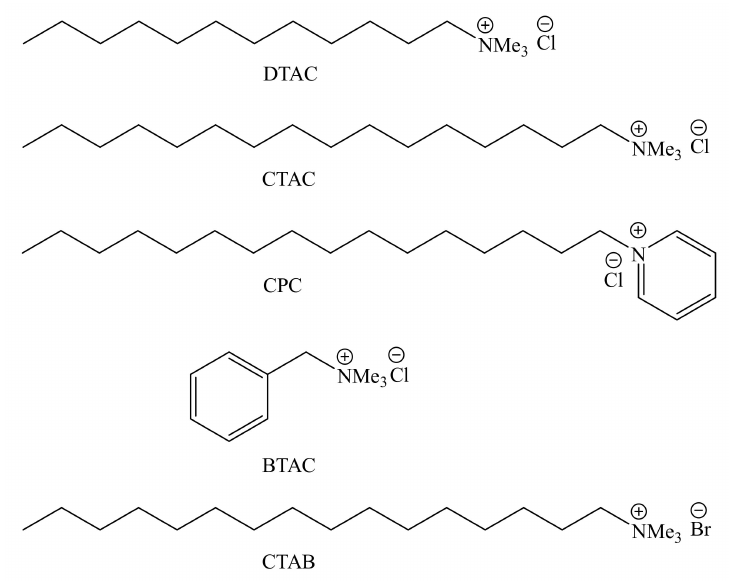
Figure 1. Chloride and bromide sources considered in the present work. A synopsis of all the investigated photocatalysts is reported in Table 1. Table 1. Synopsis of the Y%Bi-doped BiO(Cl 0.875 Br 0.125 ) photocatalysts studied in this work.